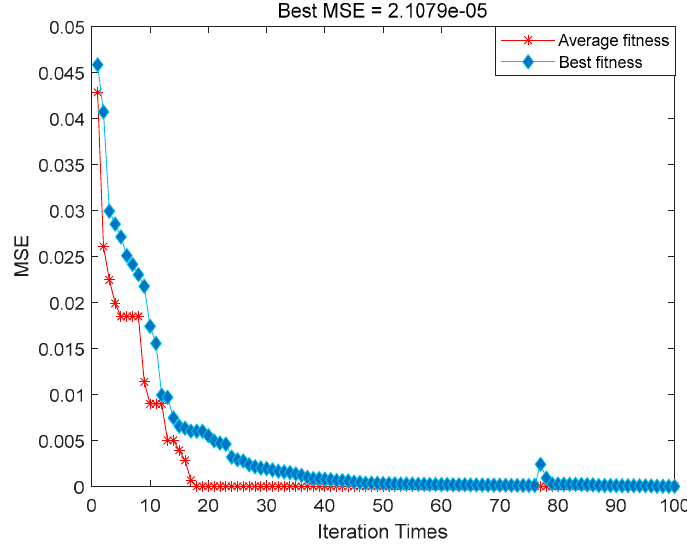
Figure 7. The fitness curve of the LAOS optimization algorithm.